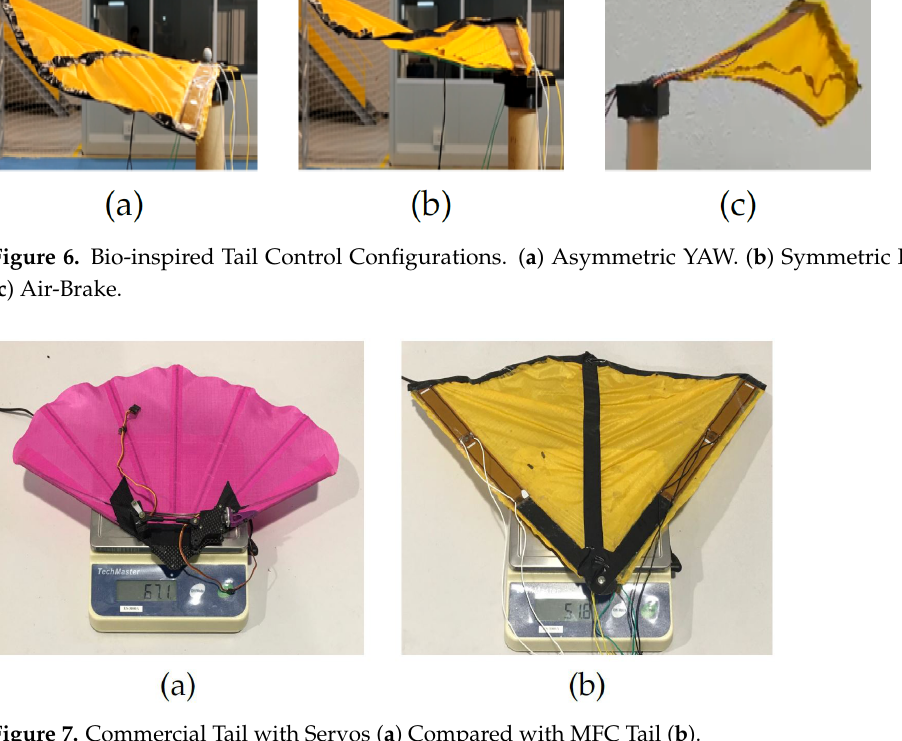
Figure 7. Commercial Tail with Servos ( a ) Compared with MFC Tail ( b ).